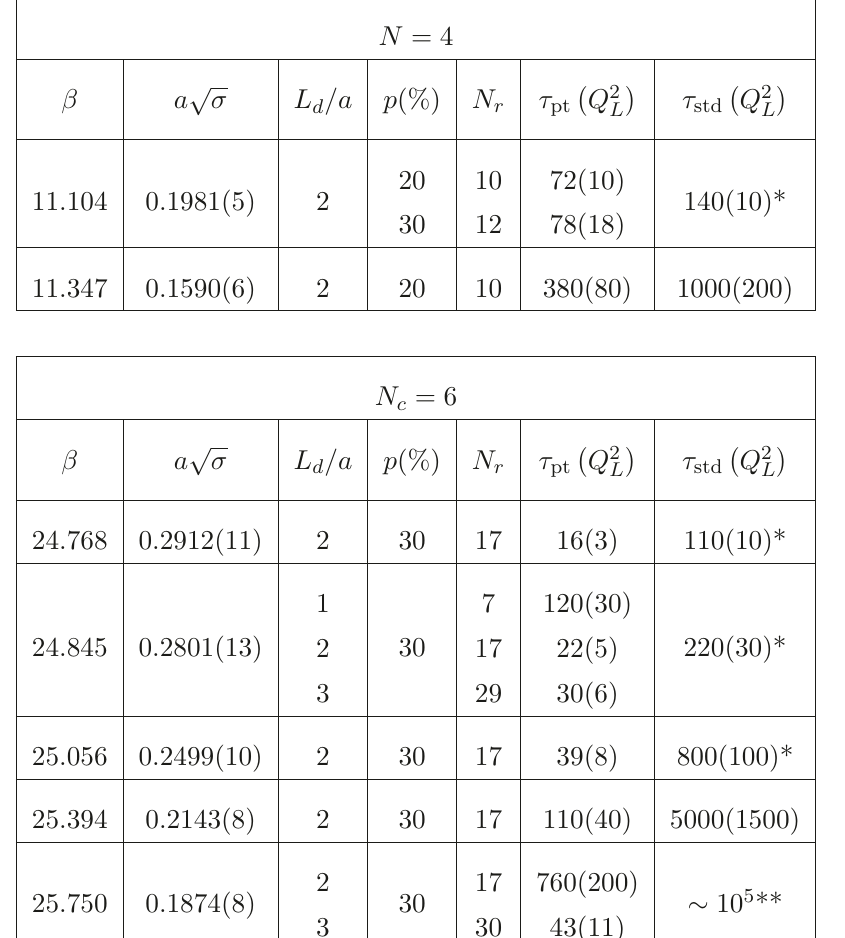
Table 2 . Results for the autocorrelation time of Q 2 Hasenbusch algorithm. Quantities denoted with used for the local update was the same of the present work. The result denoted by ** is just